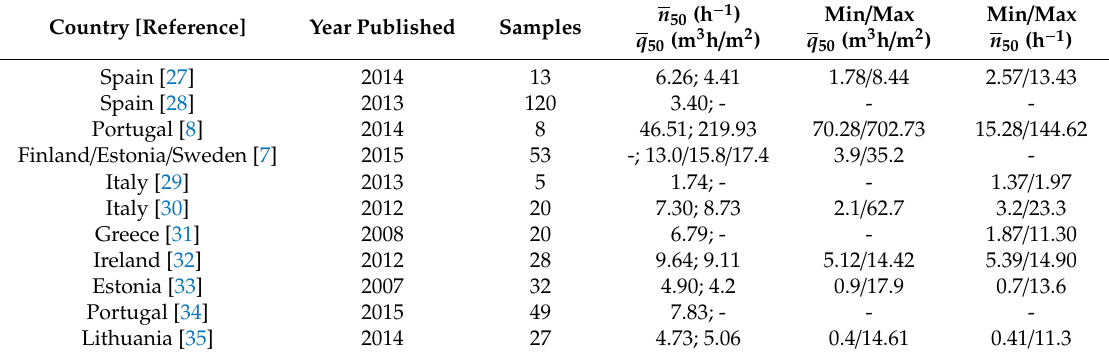
Table 3. Collection of recent publications about the airtightness in